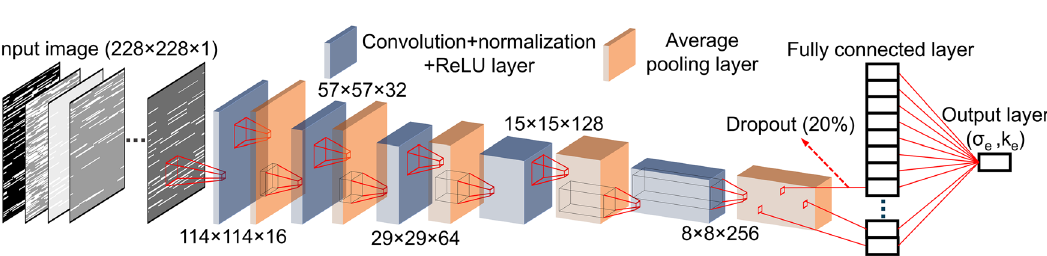
Figure 2. Schematic for the data preparation. The image data size of Cu-CNT networks is reduced by converting RGB scale into grayscale. The Cu-CNT interfacial resistance is encoded by the selection of Cu domain color intensity. The resistance levels are defined as follows. Level 1: R c = 20 kΩ or R ″ t,c = 10 −7 m 2 K/W, Level 2: R c = 2 kΩ or R ″ t,c = 10 −8 m 2 K/W, Level 3: R c = 200 Ω or R ″ t,c = 10 −9 m 2 K/W, and Level 4: R c = 20 Ω or R ″ t,c = 10 −10 m 2 K/W. The images are flipped horizontally, vertically, and diagonally to amplify the training dataset by four folds.